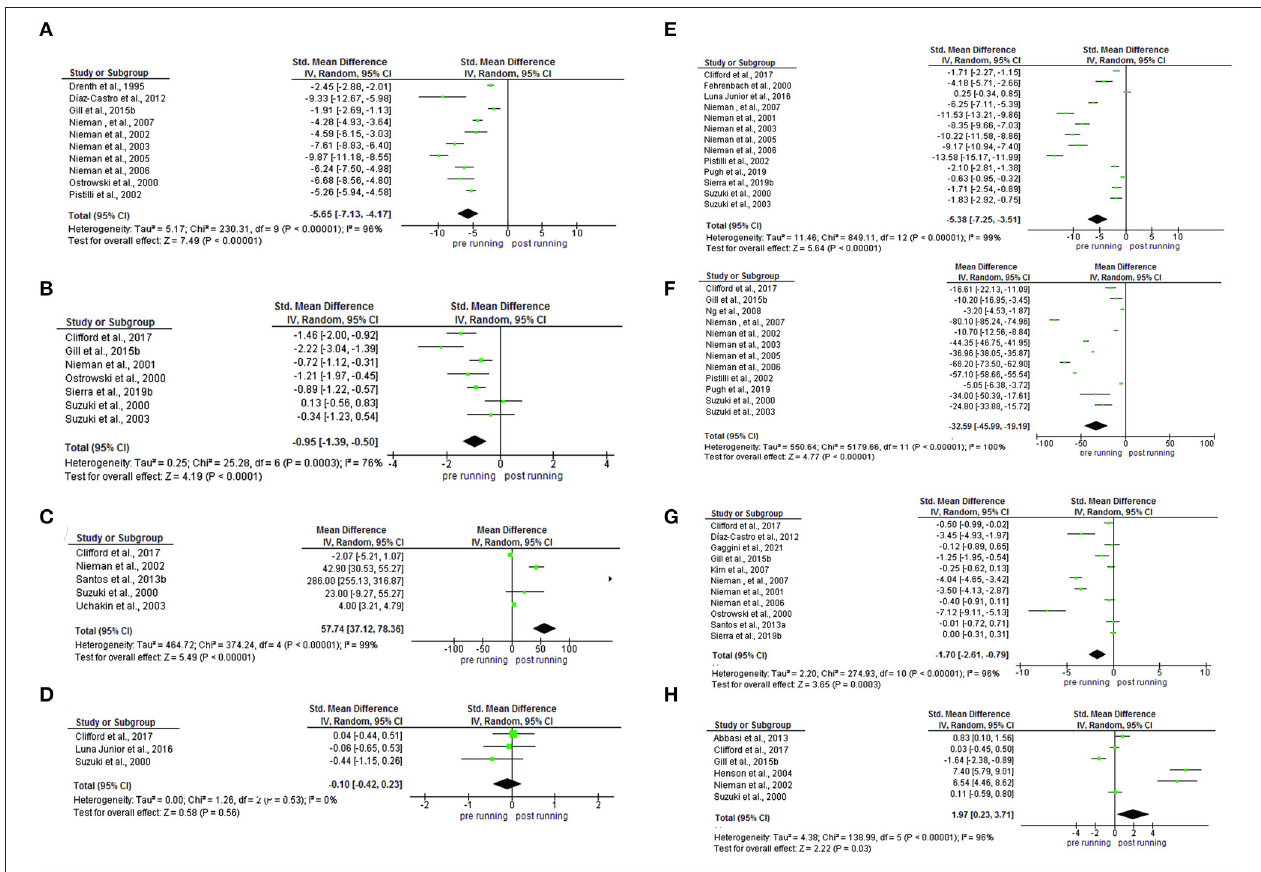
FIGURE 5 | Comparison and effect among cytokines (A) IL-1ra, (B) IL-1 β , (C) IL-2, (D) IL-4, IL (E) − 8, (F) IL-10, (G) TNF- α , and (H)